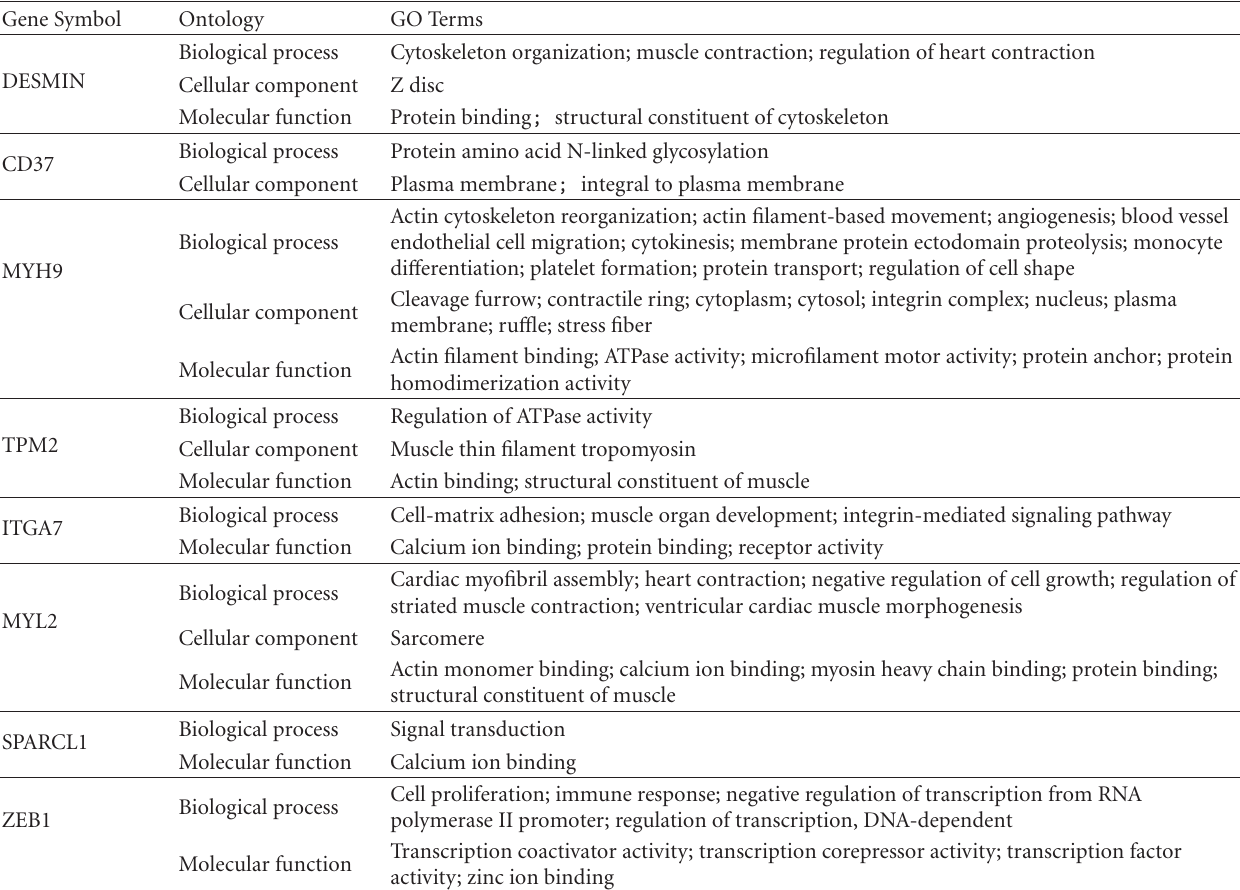
Table 4: GO annotations of eight DEC genes identified from colon dataset by MIClique.